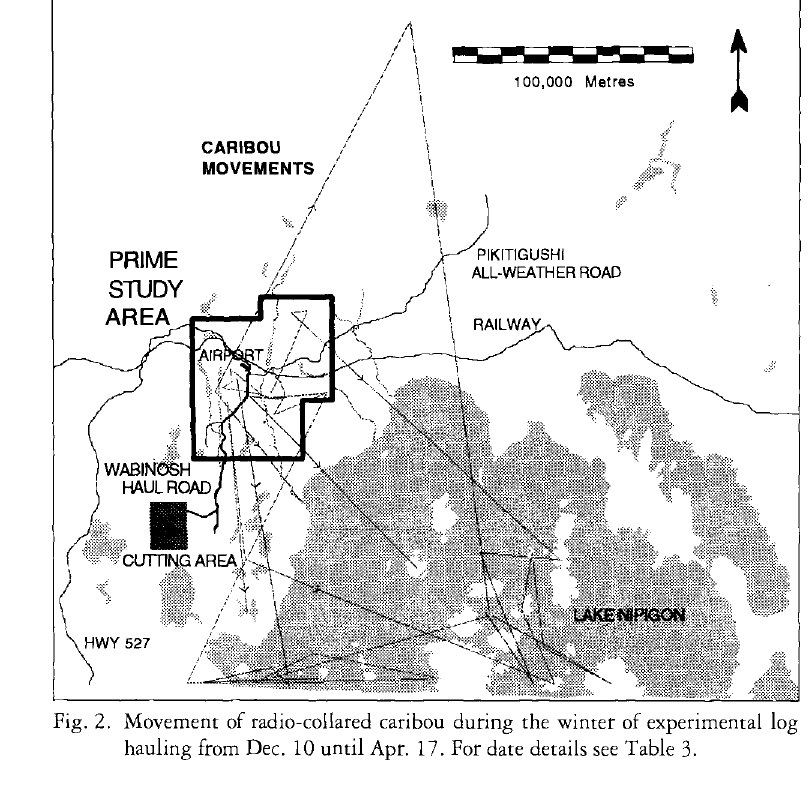
Fig. 2. Movement of radio-collared caribou during the winter of experimental log hauling from Dec. 10 until Apr. 17. For date details see Table 3.